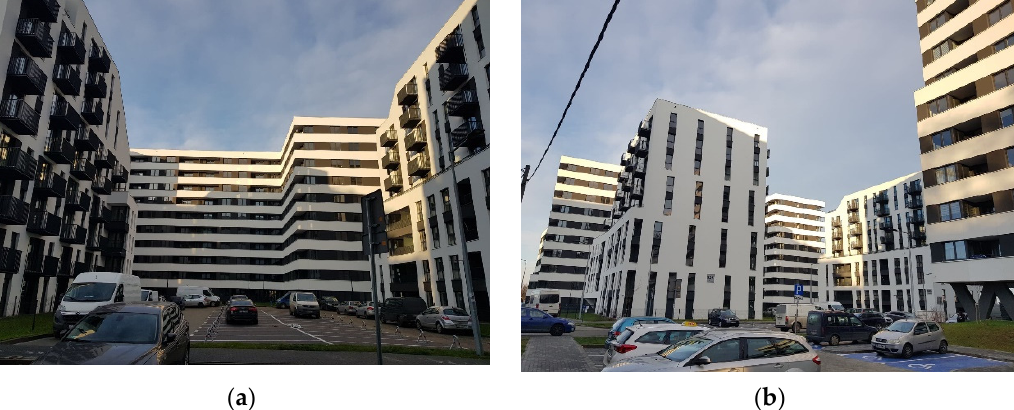
Figure 11. ( a , b ) Intensive multi-family residential development on the northern side of the Piastów housing estate. Photos: by author.